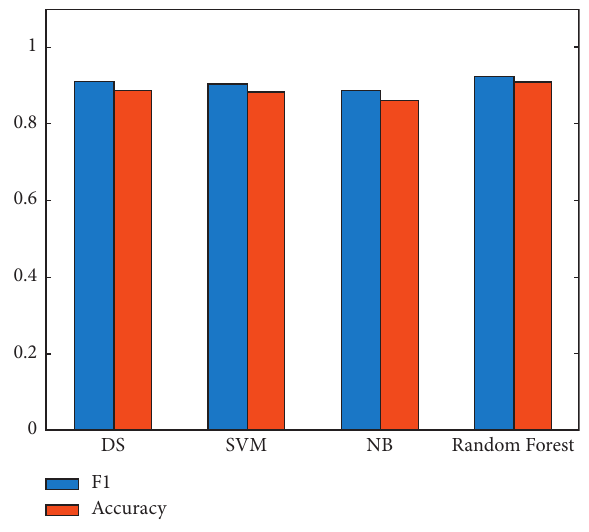
Figure 3: Comparison of F1 and